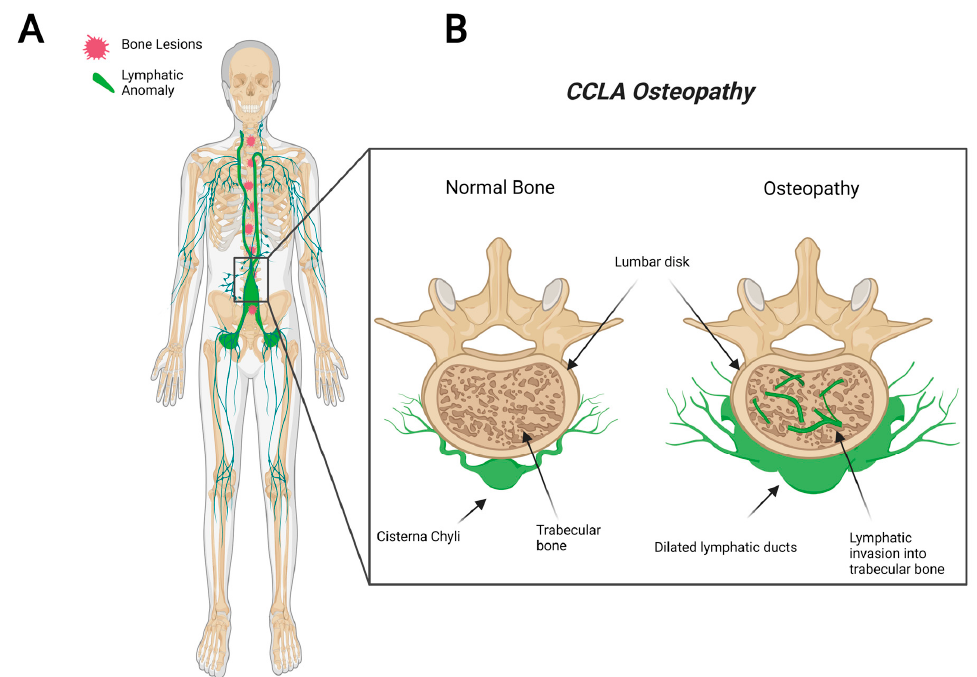
Figure 3. Visual representation of symptoms associated with Central Conducting Lymphatic Anomaly. CCLA patients fail to transport lymphatic fluid and suffer from dilated thoracic ducts. Dilated ducts invade proximal tissue and can cause boney lesions ( A ). Channel-like osseous lesions are found in the trabecular bones ( B